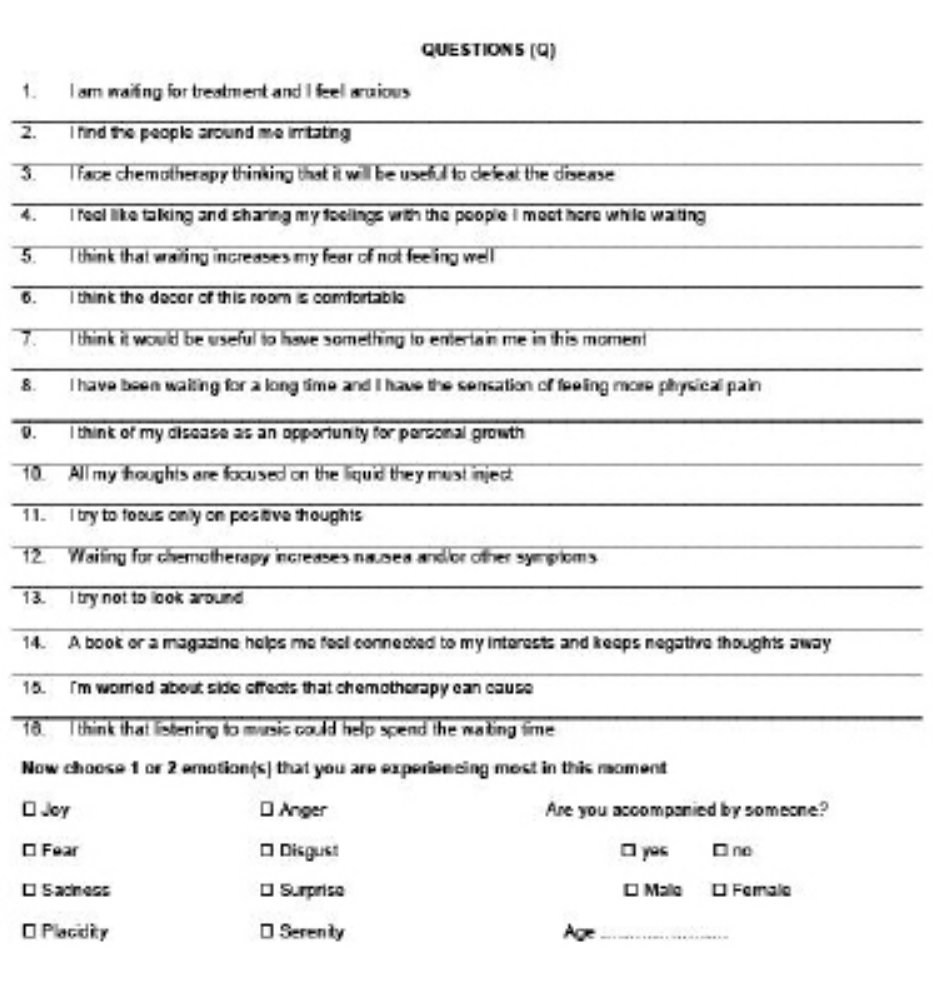
Figure 1 . Questionnaire administered in Day